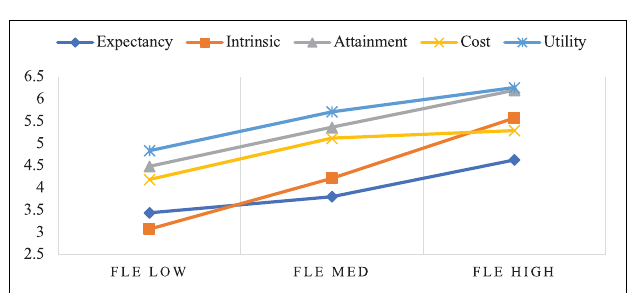
FIGURE 3 | Relationship between FLE and expectancy-value